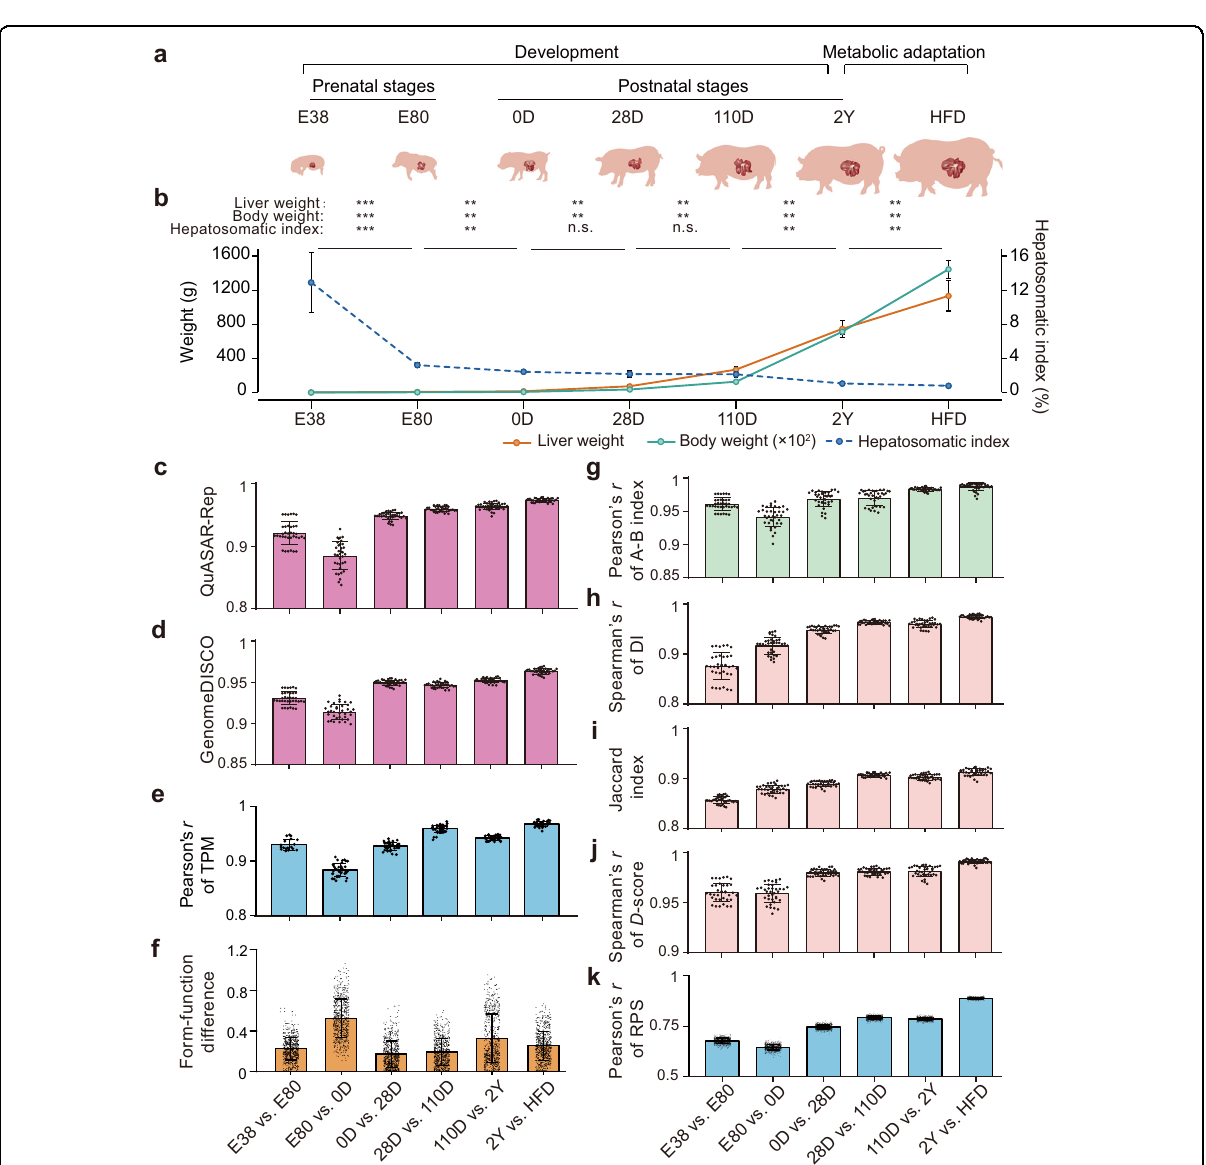
Fig. 1 Divergences in chromatin architecture and gene expression of liver during development and metabolic stress. a Schematics of liver sampling. b Comparison of the hepatosomatic index (ratio of liver to body weight) across six developmental stages and the HFD-fed pigs. Data are presented as means ± SD. P -values were calculated using a Wilcoxon rank-sum test. n.s., P ≥ 0.05; ** P < 0.01; *** P < 0.001. Notably, a rapid liver growth during prenatal development (i.e., greater proportional gain in liver weight compared to body weight) could be observed. c – h Similarities in chromatin architecture and gene expression for livers between consecutive developmental stages and HFD-fed pigs. The correlations of chromatin architecture were separately determined using c QuASAR-Rep and d GenomeDISCO for the Hi-C maps; g A-B index and h Directionality Index (DI) for 20-kb genomic bins; i Jaccard index for TADs; j D -score for consensus TADs (cTADs); and k regulatory potential score (RPS) for genes. The dots on the bars represent the replicates. The correlations between gene expression (determined by RNA-seq, e ) and the combined differences (re fl ected by the Euclidean distances, f ) in chromatin architecture (i.e., form) and gene expression (i.e., function) were also measured as described in the Materials and